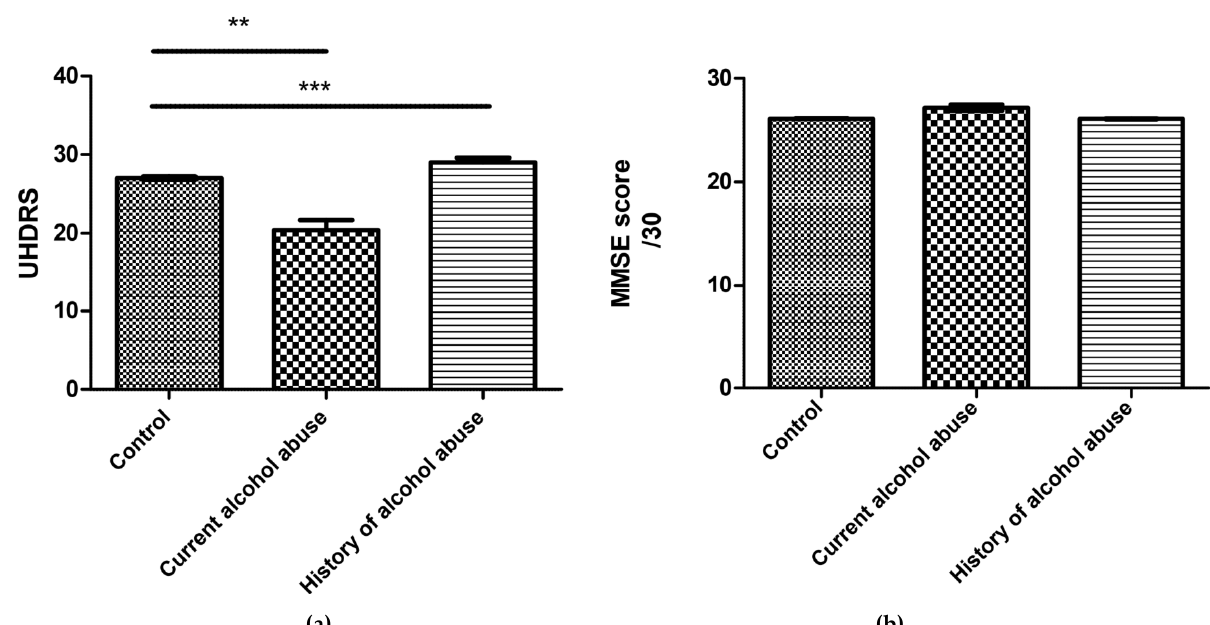
Figure 1. ( a ) Unified Huntington’s Disease Ratings Scale (UHDRS) scores, a measure of motor impairment, are lower in the control patient group, when compared with those who reported alcohol problems in the past (Kruskal–Wallis, post hoc Dunn’s, p < 0.0001); ( b ) Mini Mental State Examination (MMSE) when used as a measure of cognition is not related to alcohol or past alcohol use (Kruskal–Wallis, post hoc Dunn’s, p > 1). p values <0.01 shown as ‘**’ and p < 0.001 as ‘***’.